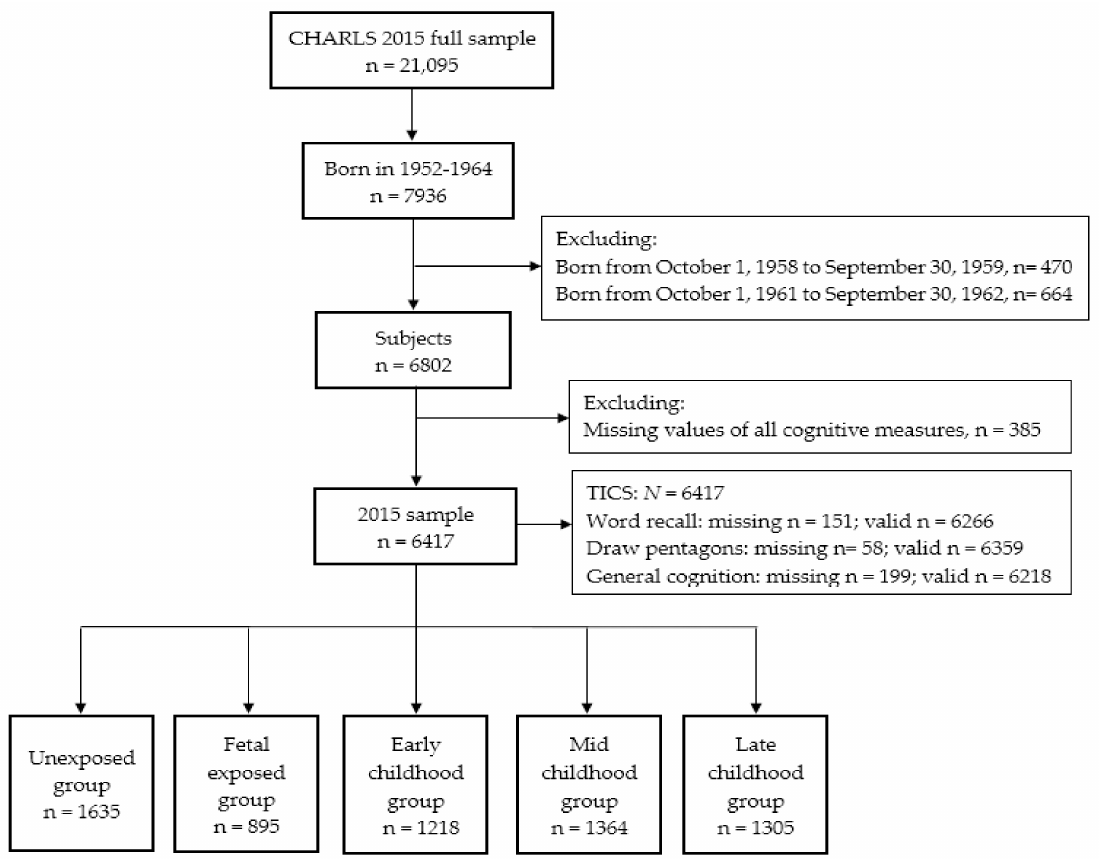
Figure 1. Flow chart of the sample selection from 2015 China Health and Retirement Longitudinal Study (CHARLS) survey. TICS: Telephone Interview of Cognitive